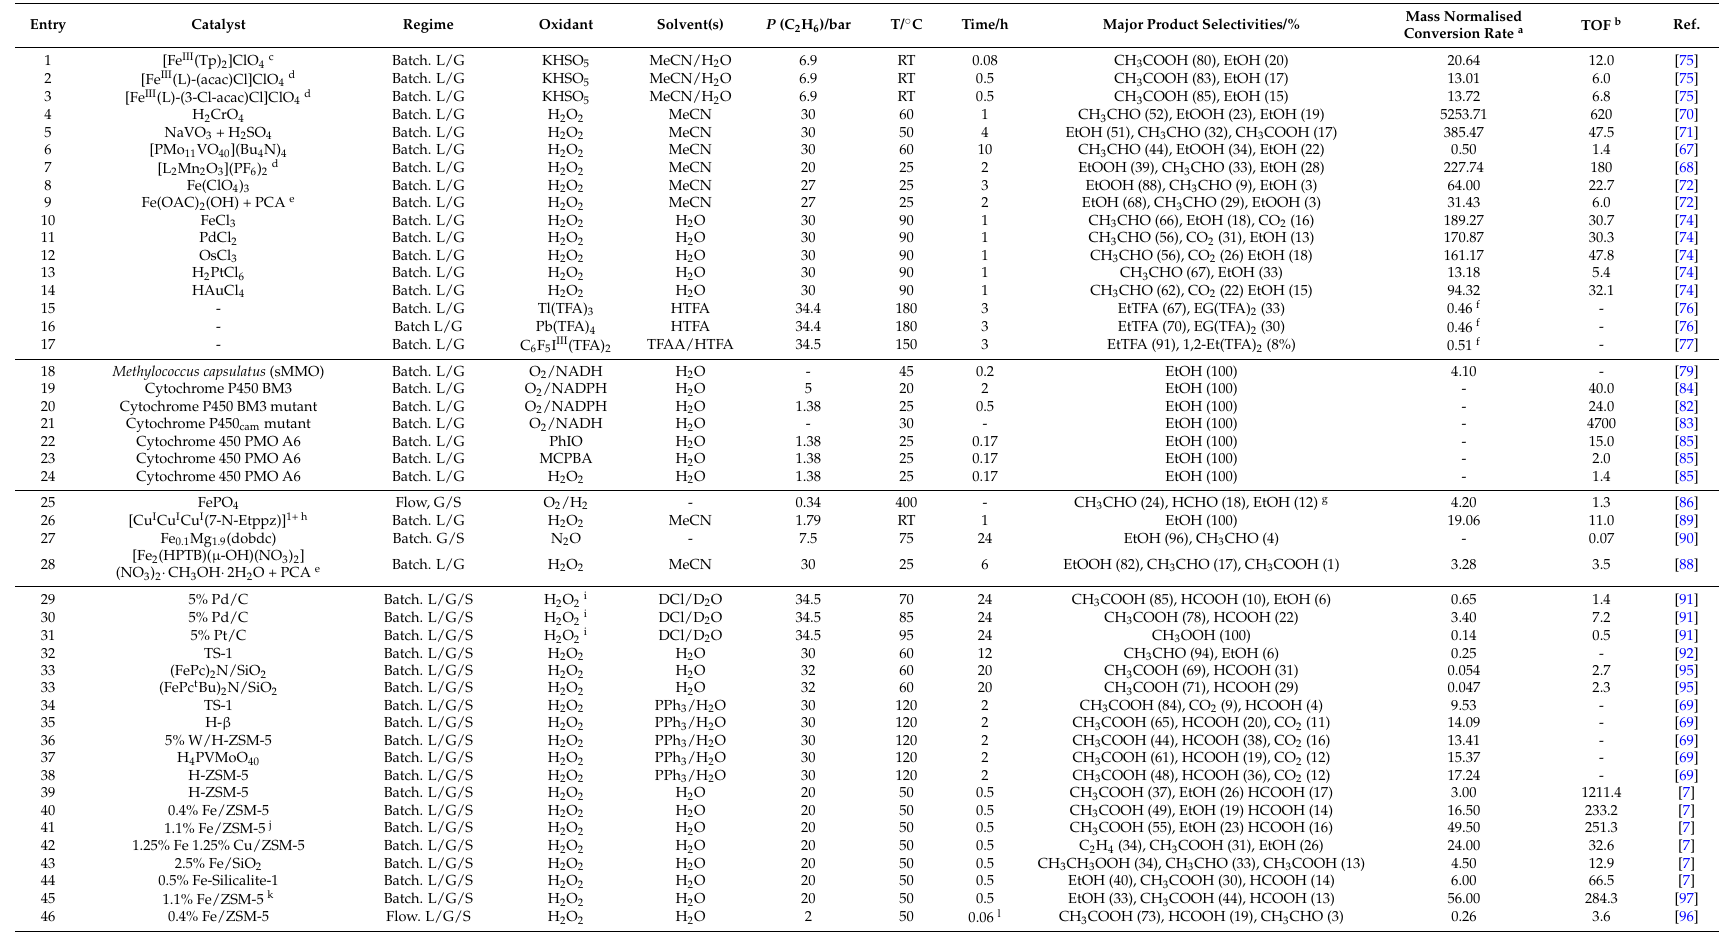
Table 1. A summary of the performance of partial ethane oxidation